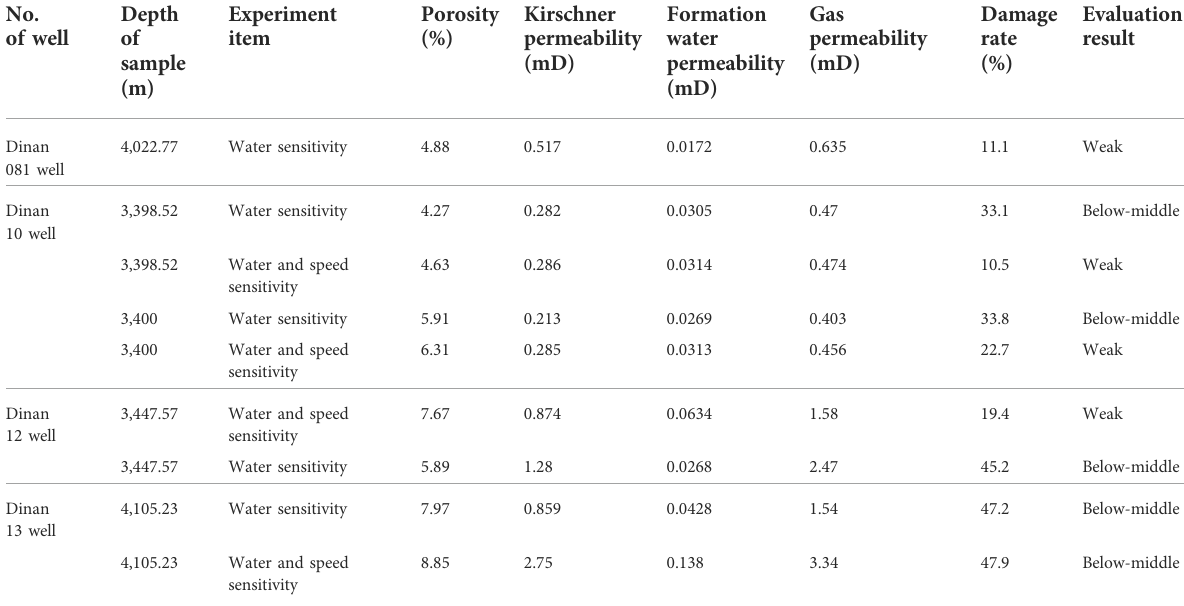
TABLE 3 Statistical list of reservoir sensitivity analysis on the Upper Wuerhe Formation of Dinan 15 block. No. of